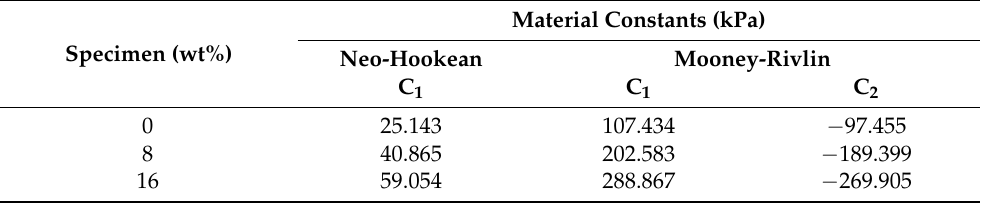
Table 2. Neo-Hookean and Mooney–Rivlin Material Constants (kPa) for specimens immersed in